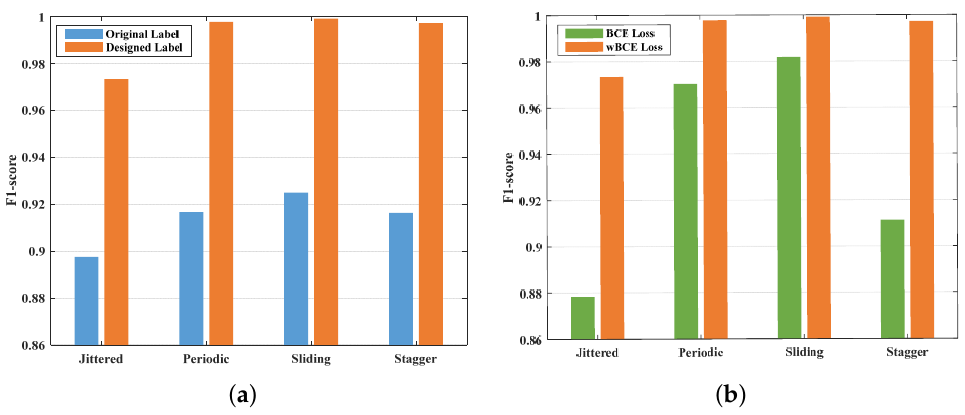
Figure 9. Influence of label configuration and wBCE loss function. ( a ) Performance comparison of original label and designed label; ( b ) Performance comparison of BCE loss and wBCE loss.